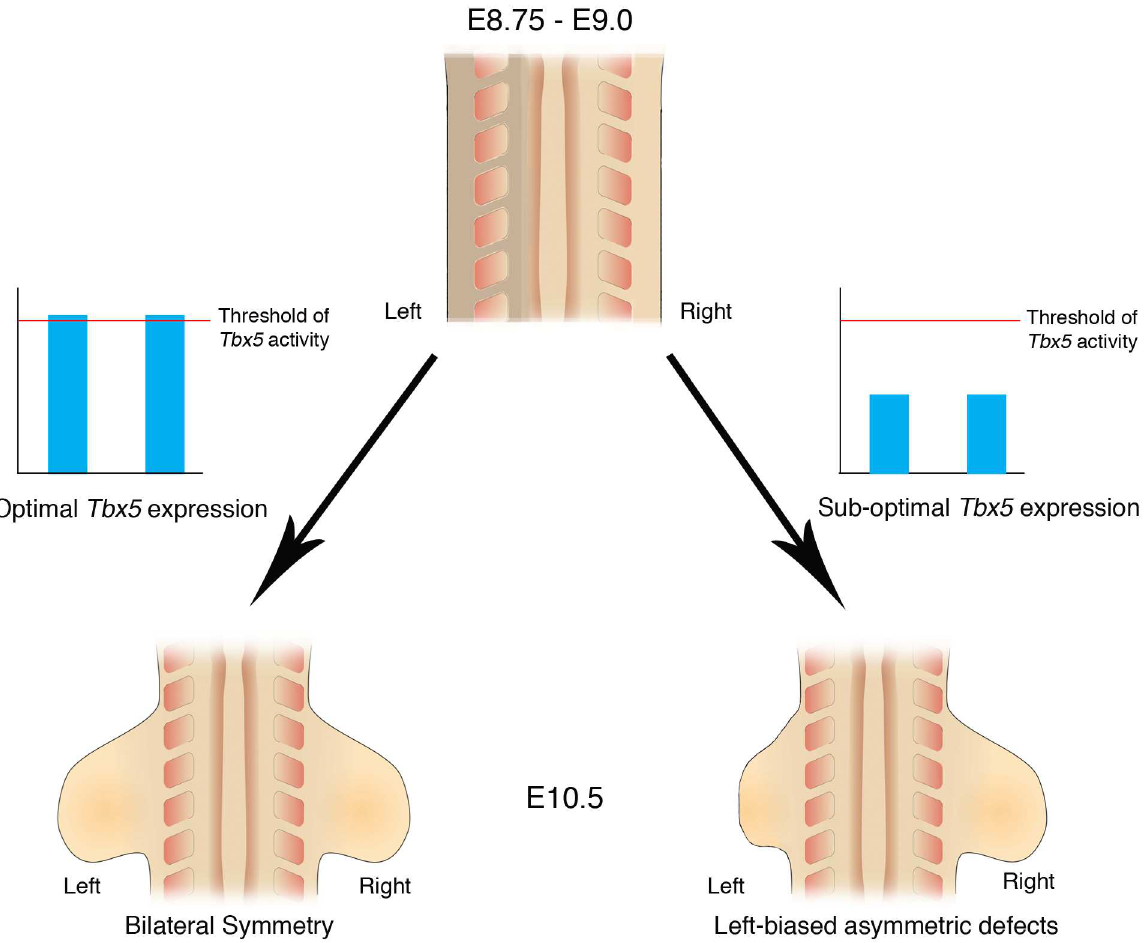
Fig 7. Schematic representation of Tbx5 buffering the inherent LPM L/R asymmetry. Bilateraloptimal Tbx5 expressionreaches abovea thresholdlevel that buffers the inherentasymmetry in the left and right LPM, which includesthe future forelimb-forming regions. Bilateral,suboptimal Tbx5 expressionlevels that fail to reach thresholdlevels leads to abnormalities in limb formation and cannot buffer the inherentasymmetry in the LPM and as a result the left limb is more severely affected by loweredTbx5 activity than the right